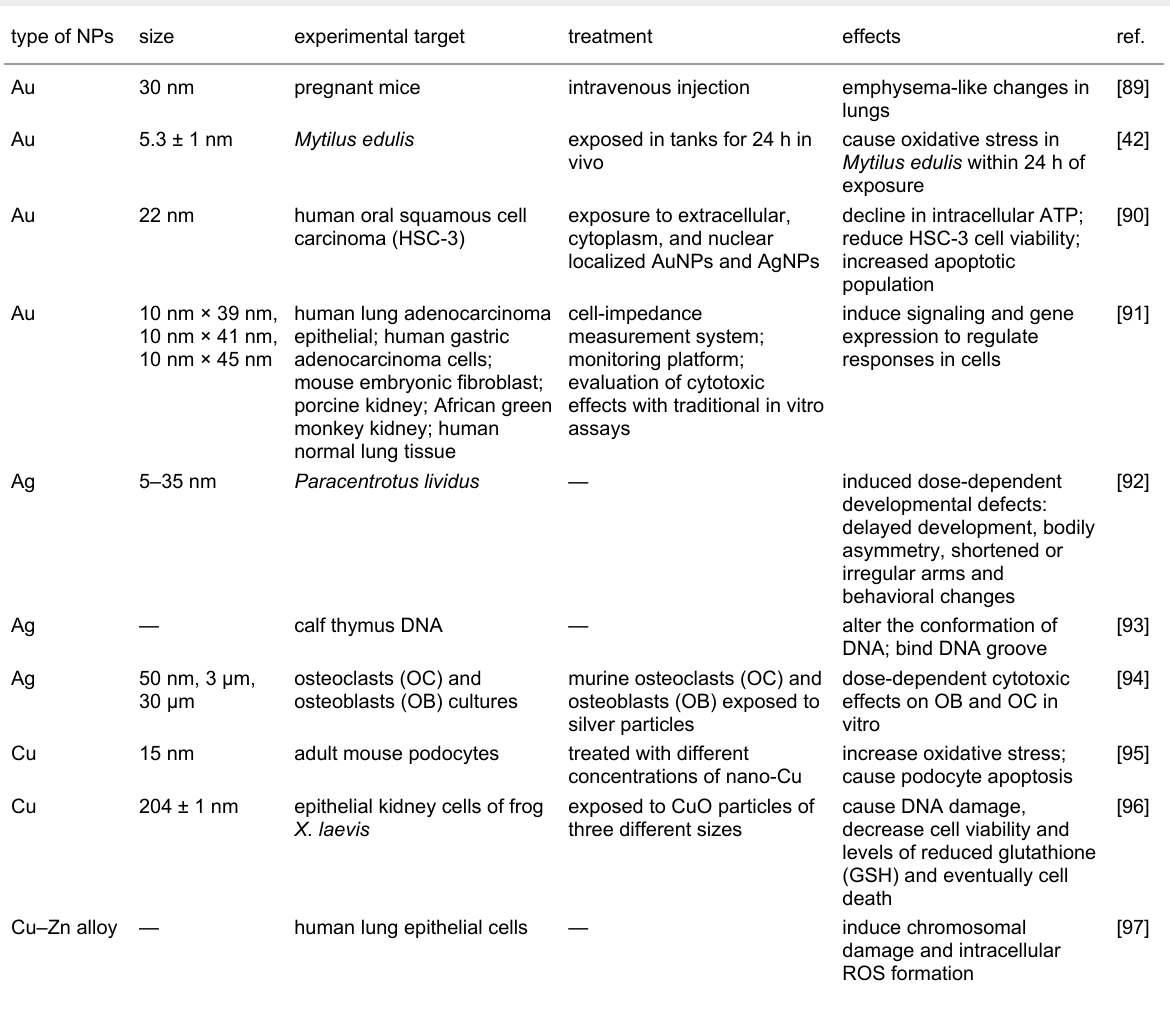
Table 1: Side effects of